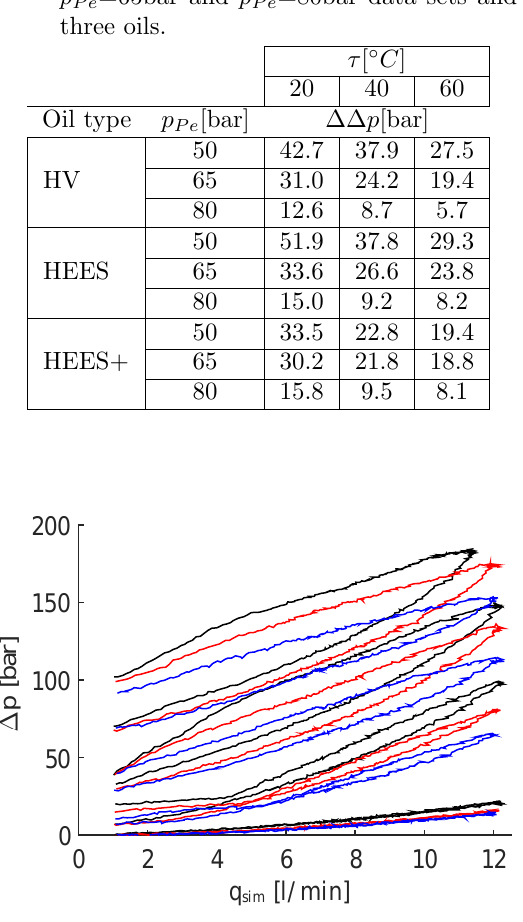
Figure 14: ∆ p (q) for HV at 20(black), 40(red), and 60 ◦ C(blue).